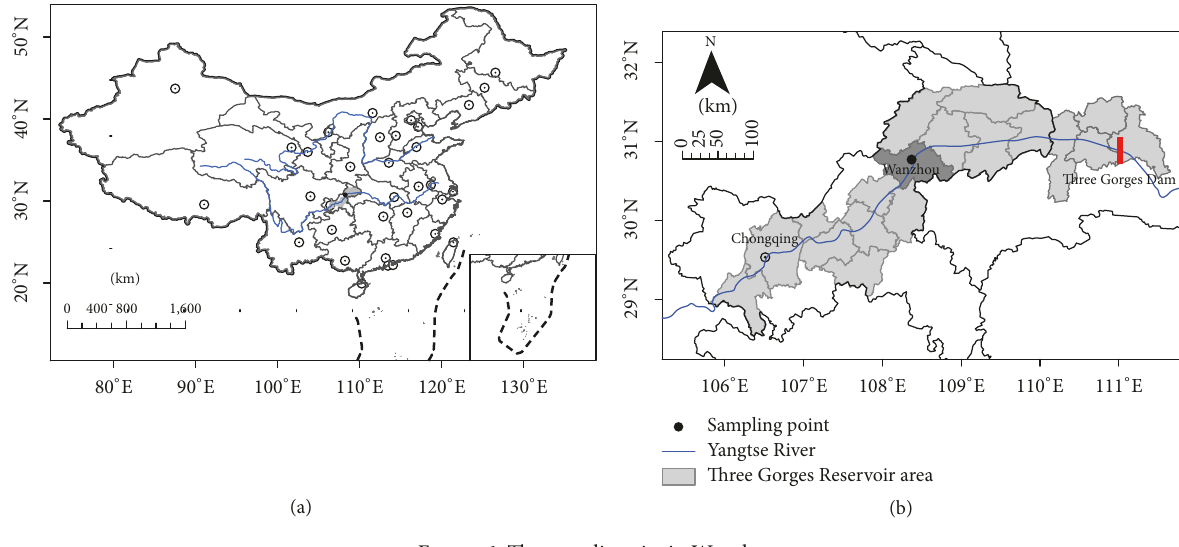
Figure 1: The sampling site in